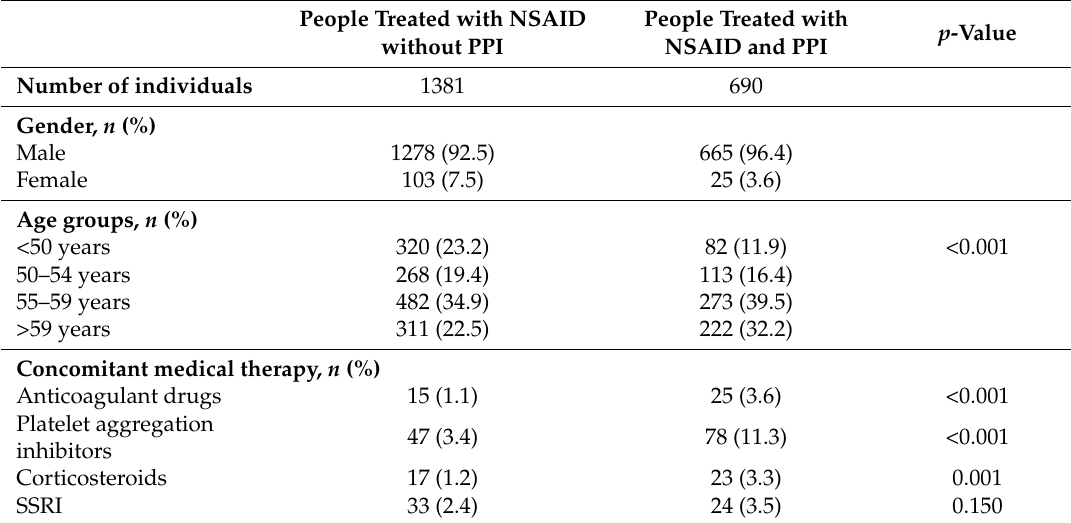
Table 2. Characteristics of individuals treated with non-steroidal anti-inflammatories (NSAID) or NSAID and proton pump inhibitors and concomitant drugs at a high risk of gastrointestinal events. People Treated with NSAID